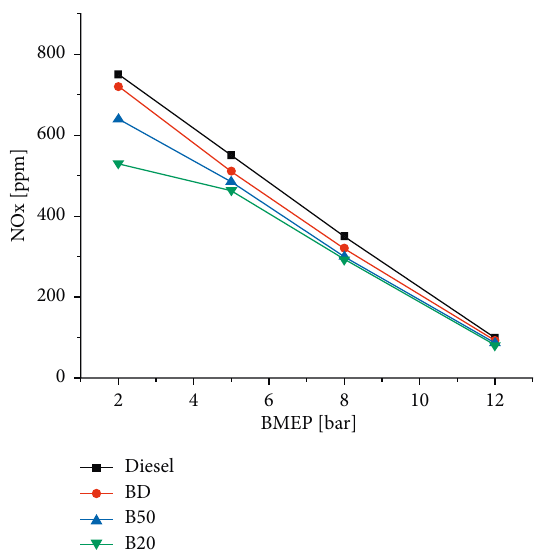
Figure 10: NOx emission with bmep @